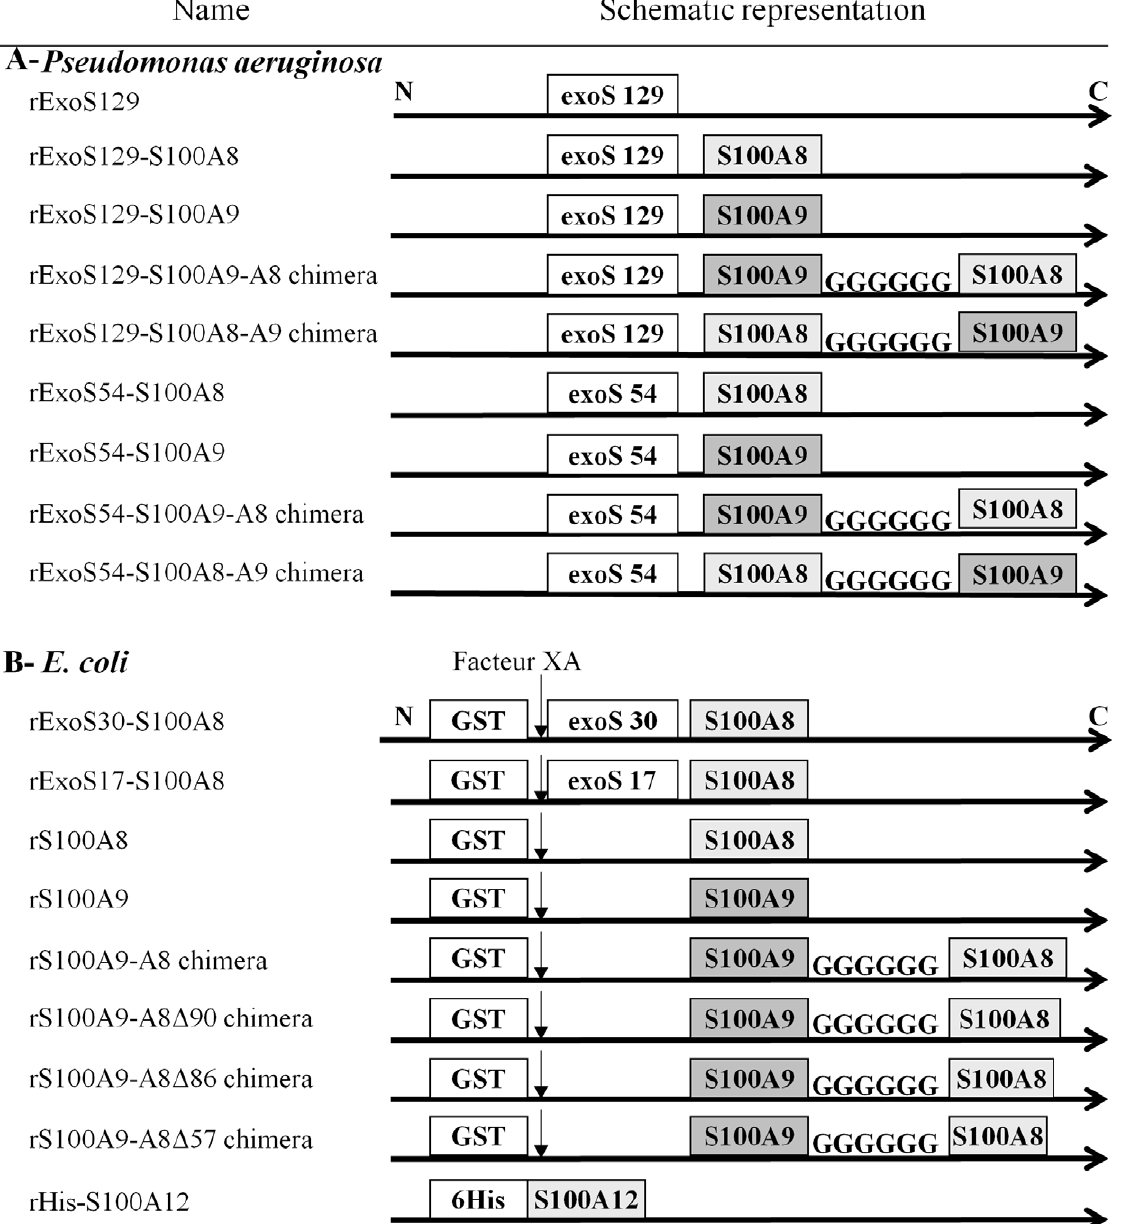
Figure 2. Schematic representation of the recombinant proteins. (A) Proteins expressed in Pseudomonas aeruginosa . The name of recombinant proteins matched with the represented schematic constructions. S100A8 and S100A9 are in frame with ExoS129 or ExoS54. Chimera proteins are the result of the binding of S100A8 with S100A9 by 6 Glycine amino acid residues. (B) In E. coli, recombinant S100 proteins are fused to GST and produced by a pGEX5x2 plasmid. The GST cleavage is performed by the XA factor. Some S100A9-A8 chimera proteins are truncated ( D ) at the C-terminal part of S100A9-A8, at amino acid 90 ( D 90), 86 ( D 86) or 57 ( D 57) compared to the full length S100A9-A8.